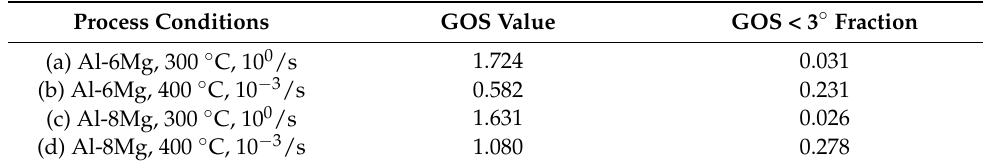
Figure 6. GOS maps of the ( a ) Al-6Mg, 300 °C, 10 0 /s, ( b ) Al-6Mg, 400 °C, 10 − 3 /s, ( c ) Al-8Mg, 300 °C, 10 0 /s, and ( d ) Al-8Mg, 400 °C, 10 − 3 /s. The green grains have average GOS under 3°. Table 2. Grain orientation spread value for each compression condition.